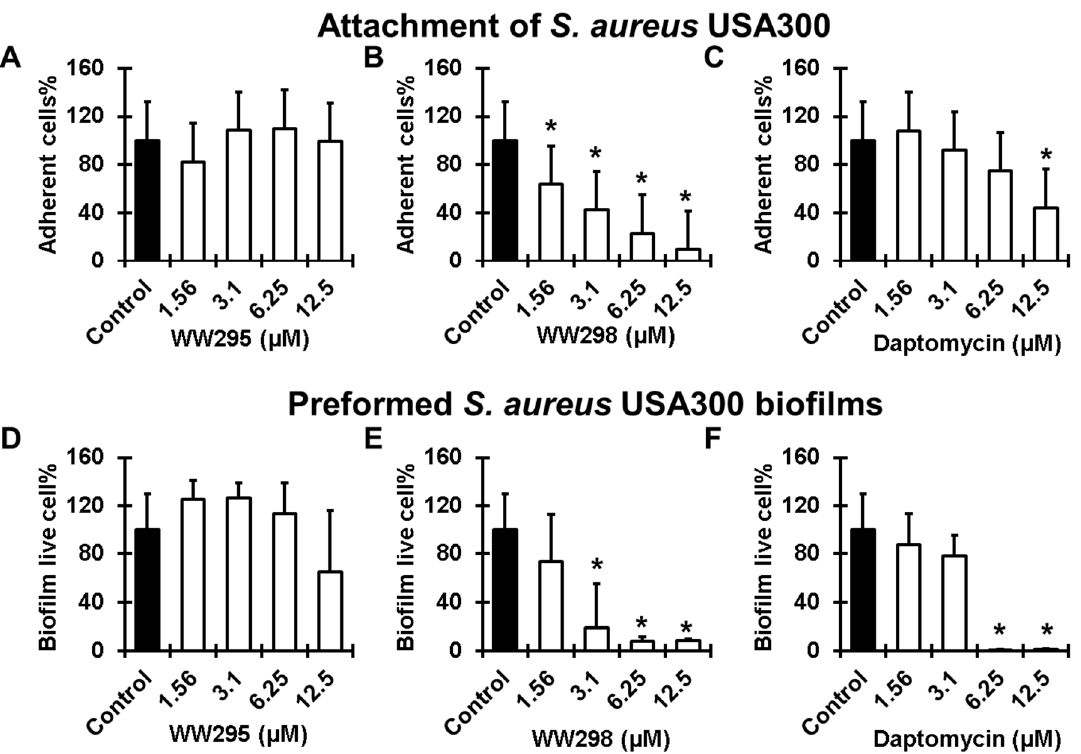
Figure 6. Concentration-dependent antibiofilm capability of WW295 and WW298 against S. aureus USA300 LAC in comparison to daptomycin. Inhibition of the first stage of attachment (adherence) of high-density bacteria onto polypropylene substrates ( A – C ), and disruption of 24 h matured biofilms ( D – F ) by WW295, WW298 and daptomycin, respectively. Statistical significance was calculated using a paired student t -test, and a p -value < 0.05 was considered significant (*).